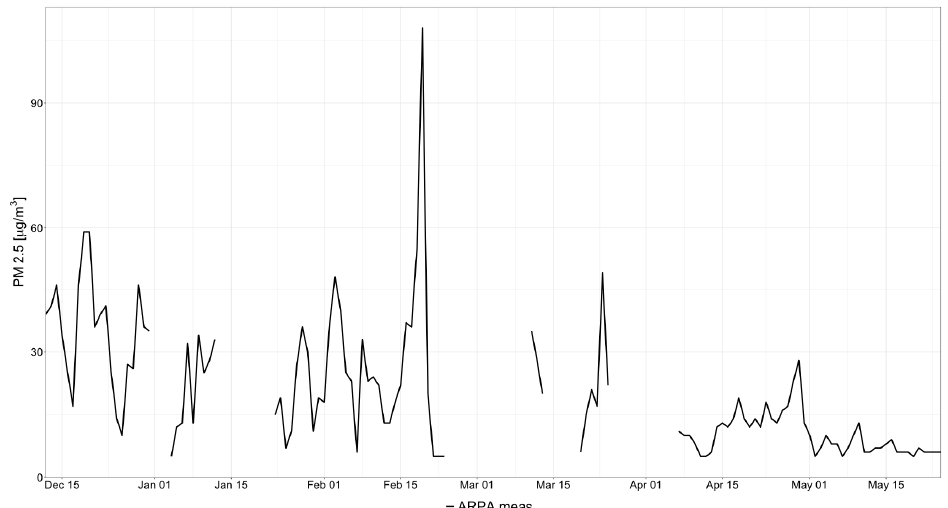
Figure 7. Concentrations of PM 2.5 ( µ m/m 3 ) detected by Stazione Arpa Torino Lingotto, over the same time span of the study.